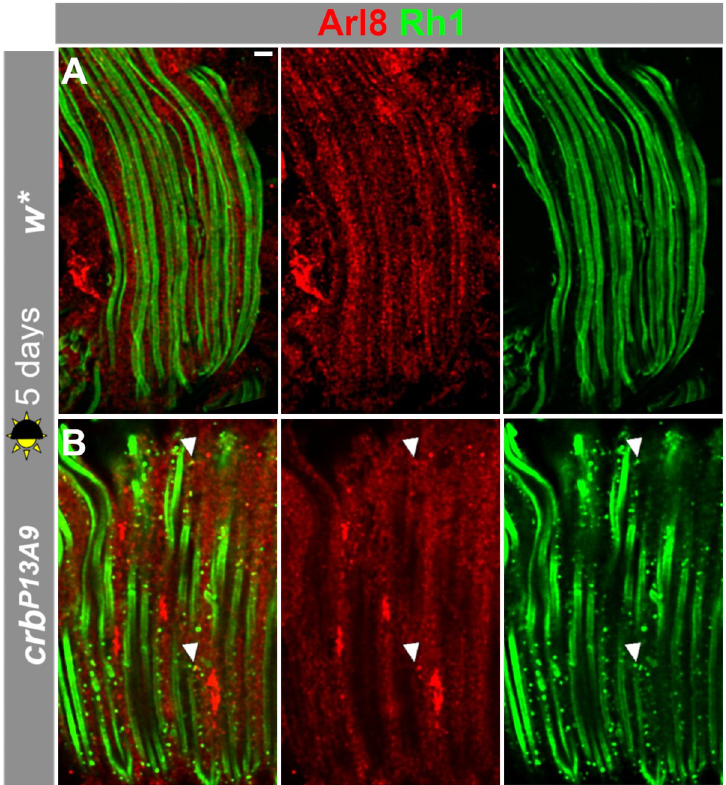
Fig 4. Arl8- and Rh1-positive compartments are largely non-overlapping in crb P13A9 and w � under normal light conditions. Longitudinal optical sections of w � (A) and crb P13A9 (B) retinas of flies kept for 5 days in 12h light/12h dark, stained for Arl8 (red), and Rh1 (green). Note that the mutant retina contains more Rh1-positive vesicles, which are rarely positive for Arl8 (arrowheads). Scale bar: 5 μ m.